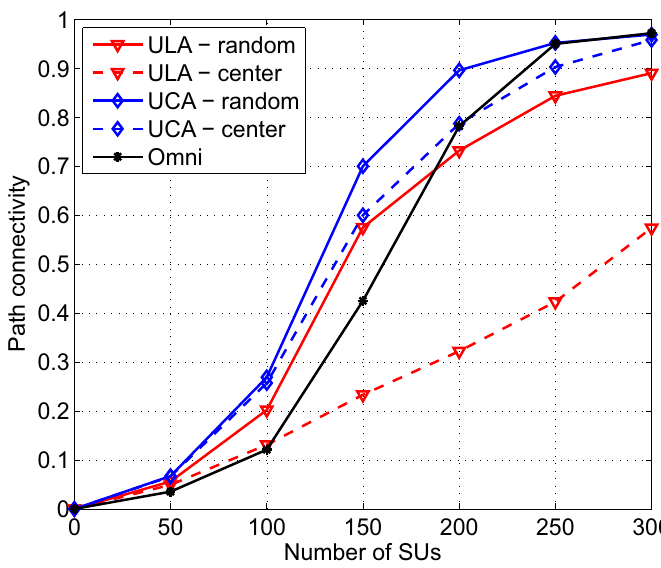
Figure 6. Path connectivity corresponding to different kinds of antennas and beamforming schemes as a function of the number of SUs; a = 500 m, M = 6, N P = 3, λ P = 0.1, α = 3, γ th = 50 dB.